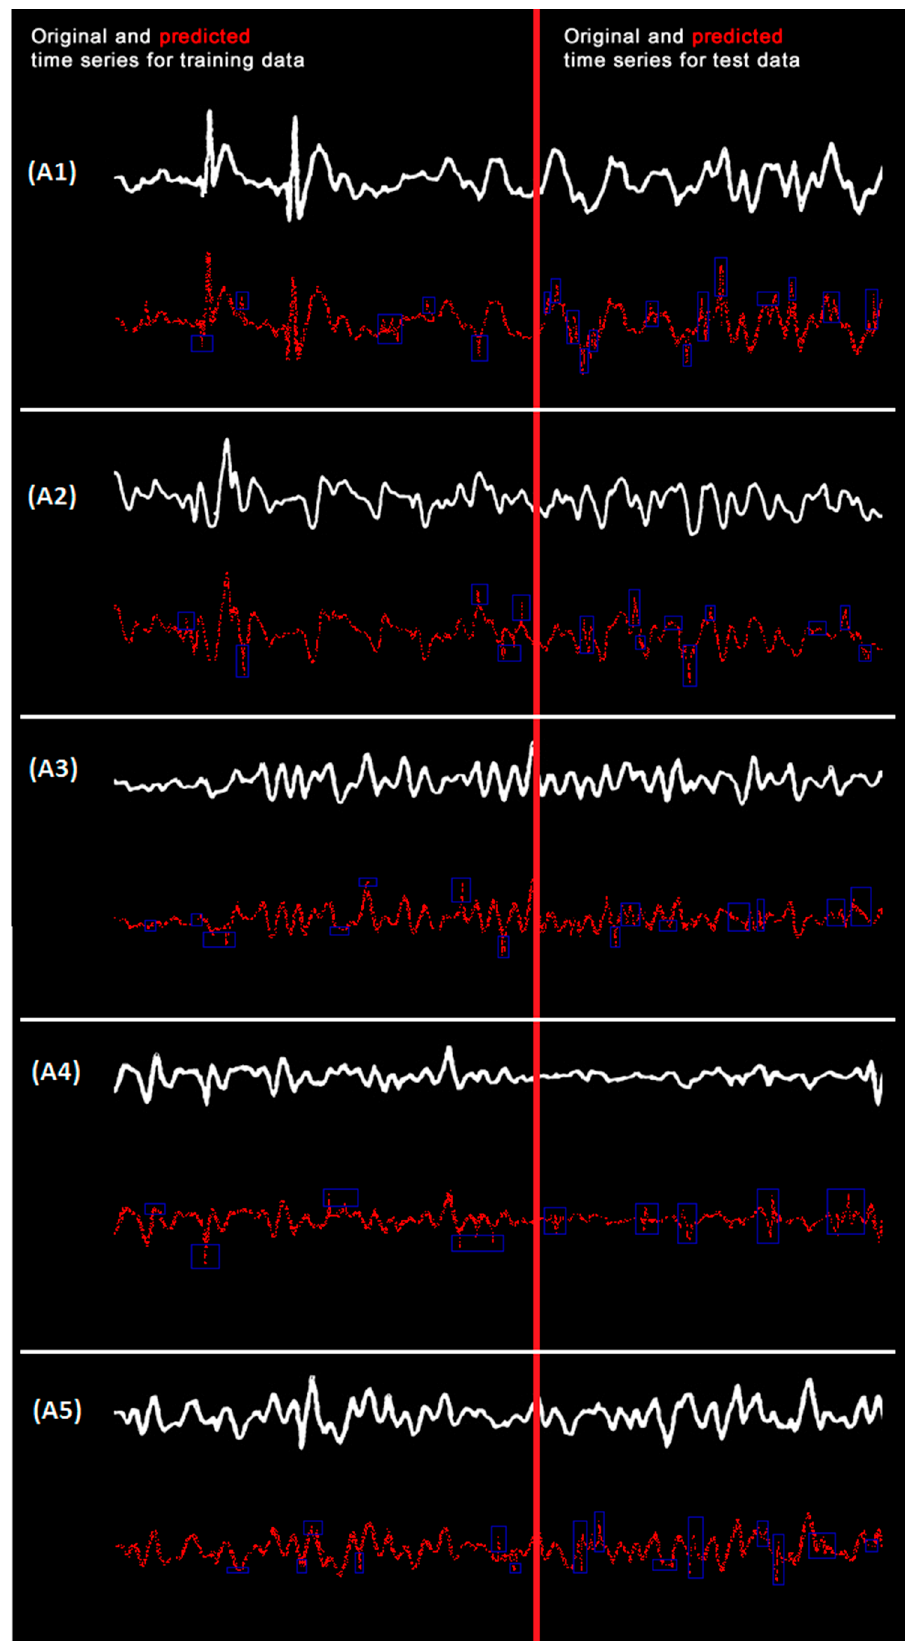
Figure 7. Predictions for both training and test data regarding the EEG time series: A1 – A5 (the white line represents original data, and the red dots are for predictions. Some visible and remarkable periods including errors are represented by blue squares).